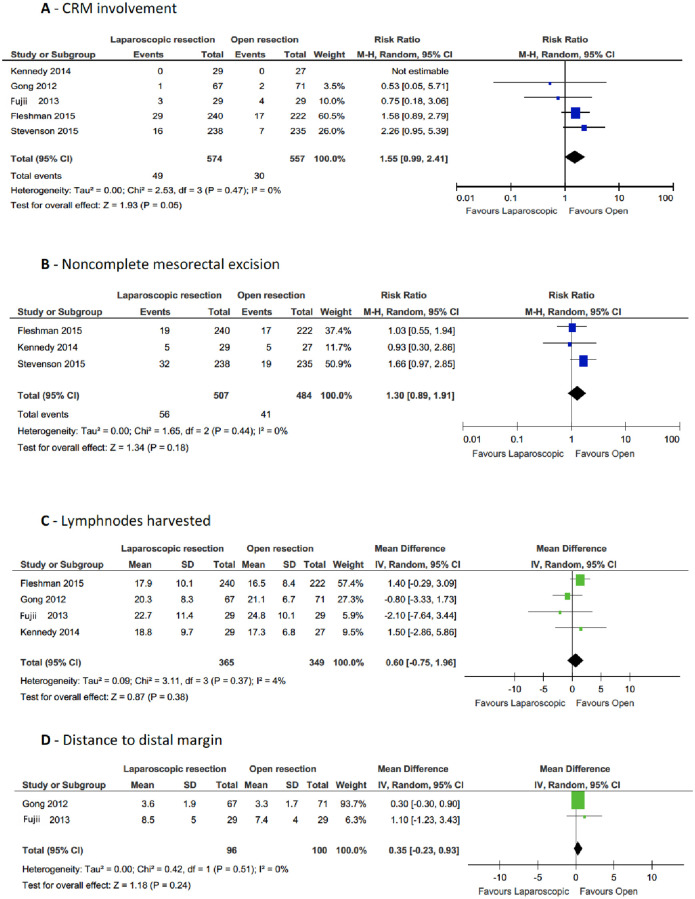
Forest plot of pathological outcomes.